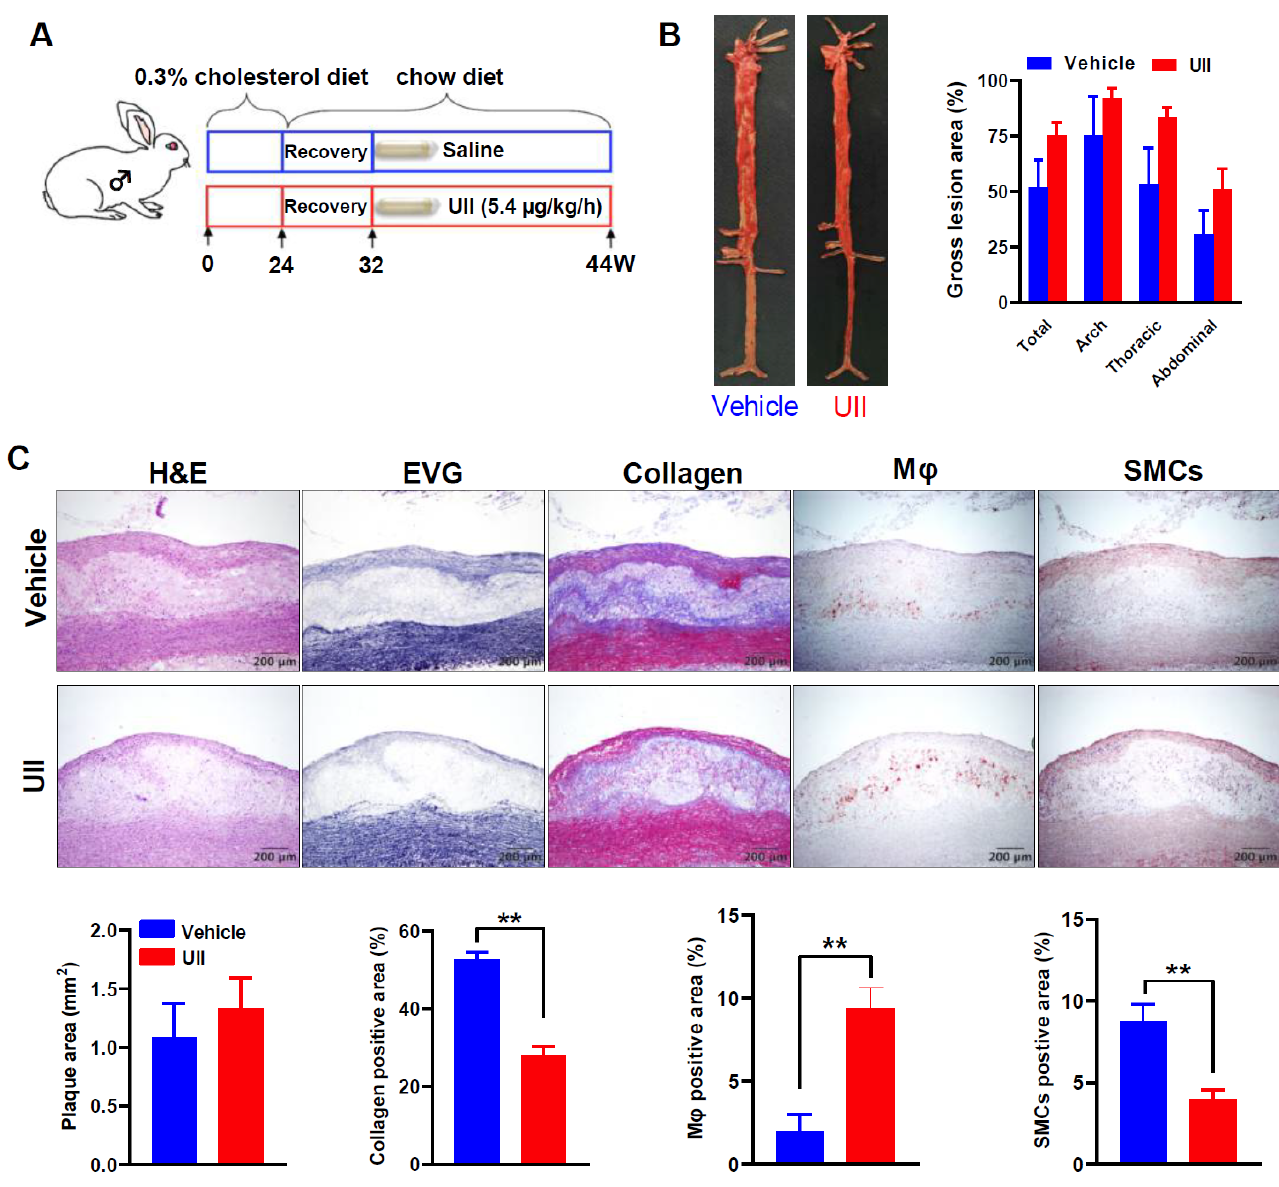
Figure 5. UII delays the regression of atherosclerosis in rabbits. ( A ) Study design: advanced atherosclerosis was induced by HCD feeding for 24 weeks, then changed to chow diet for 8 weeks recovery for plasma cholesterol decreased to a normal level, and UII (5.4 μ g/kg/h) or saline was infused for another 12 weeks. ( B ) Representative images of aortas after Sudan IV staining and their gross lesional quantification. ( C ) Representative microscopic images and quantifications of immunohistochemical staining. All data are expressed as mean ± SEM. n = 5–6 per group. ** p < 0.05 vs. vehicle group.